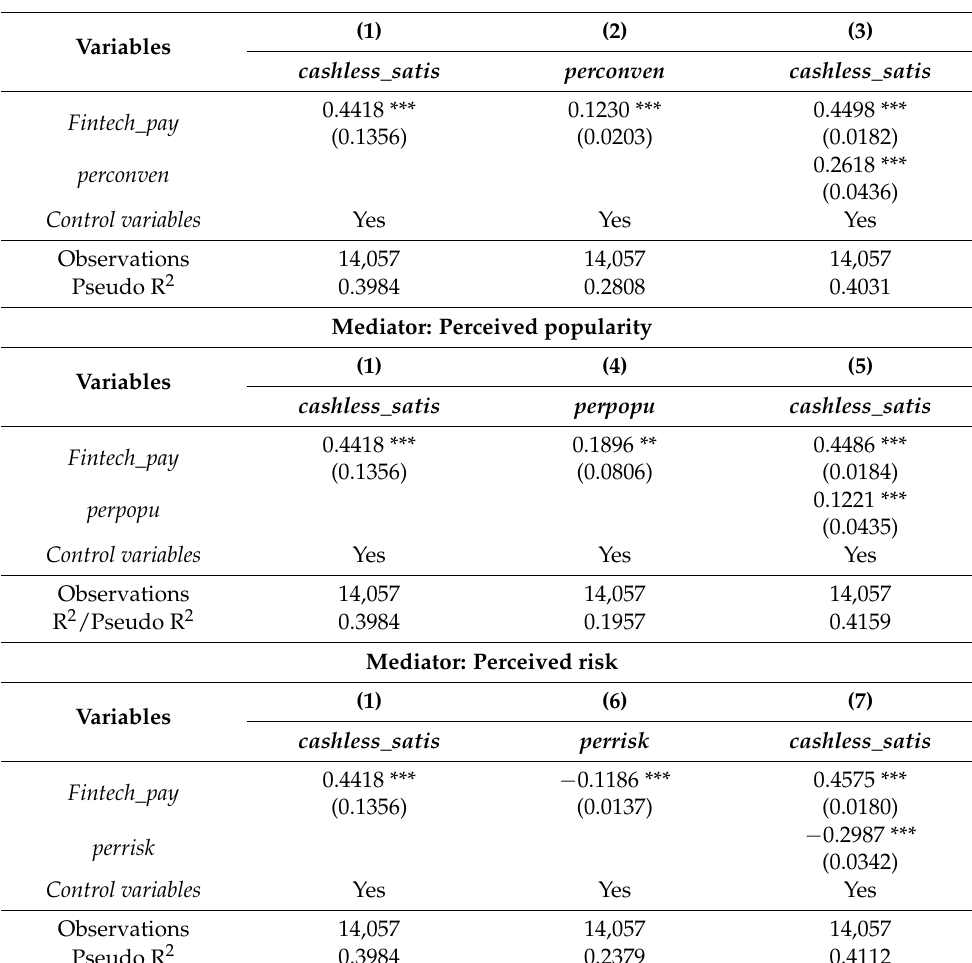
Table 6. Perceived